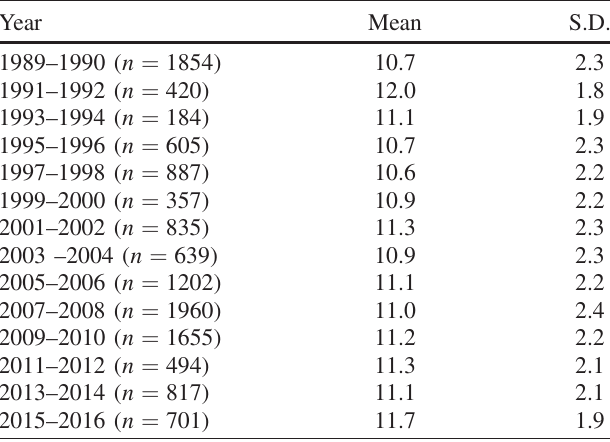
TABLE V. Average science knowledge scores over